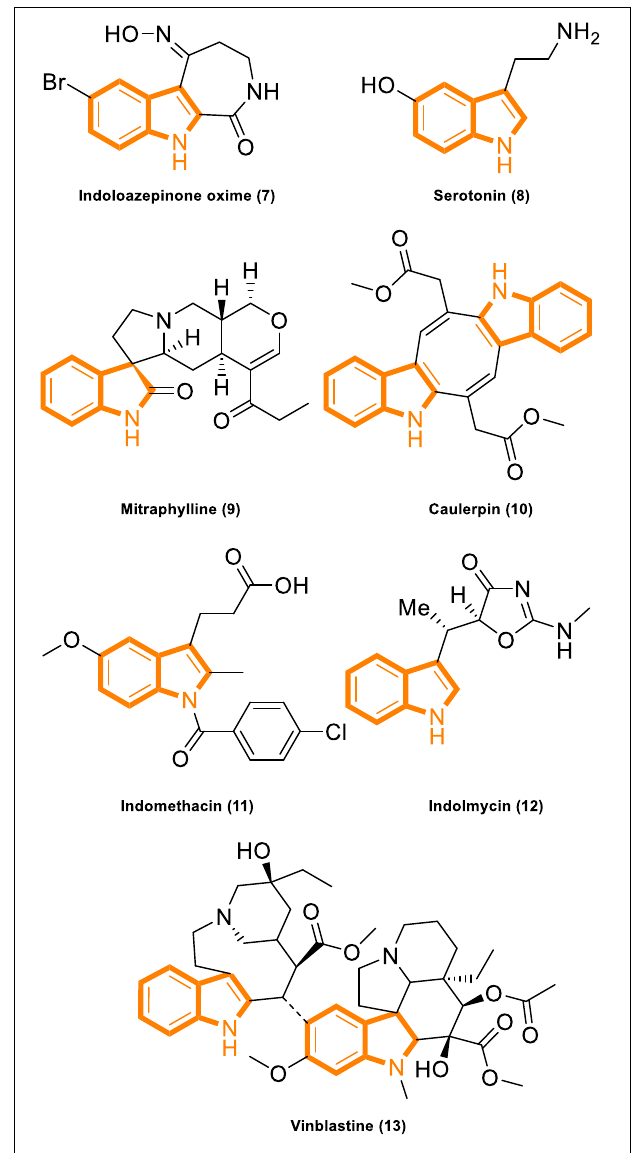
FIGURE 2 | Indole derivatives with characterized activity. (7). Indoloazepinone oxime is derived from marine products with anticancer properties (White et al., 2012). (8). Serotonin is a neurotransmitter with activities that modulate central and peripheral nervous system functions (Watanabe et al., 2011). (9). Mitraphylline activates neutrophils that contribute to the attenuation of inflammatory episodes (Montserrat-de la Paz et al., 2016). (10). Caulerpin synergizes with the glycolytic inhibitor 3BP to inhibit cellular proliferation in vitro and in vivo (Yu H. et al., 2017). (11). Indomethacin is a non-steroidal anti-inflammatory drug (Nalamachu and Wortmann, 2014). (12). Indolmycin is a potential topical agent for the control of staphylococcal infections (Hurdle et al., 2004). (13). Vinblastine is an antineoplastic agent (Haque et al.,